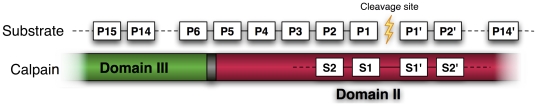
Schematic representation of contact region between calpain and substrate sequence.Domain II is the protease domain of calpain, while domain III binds . Amino acid sequences of domain III are less conserved than those of domain II, which are highly conserved not only between - and m-calpains but also among all calpain family members.